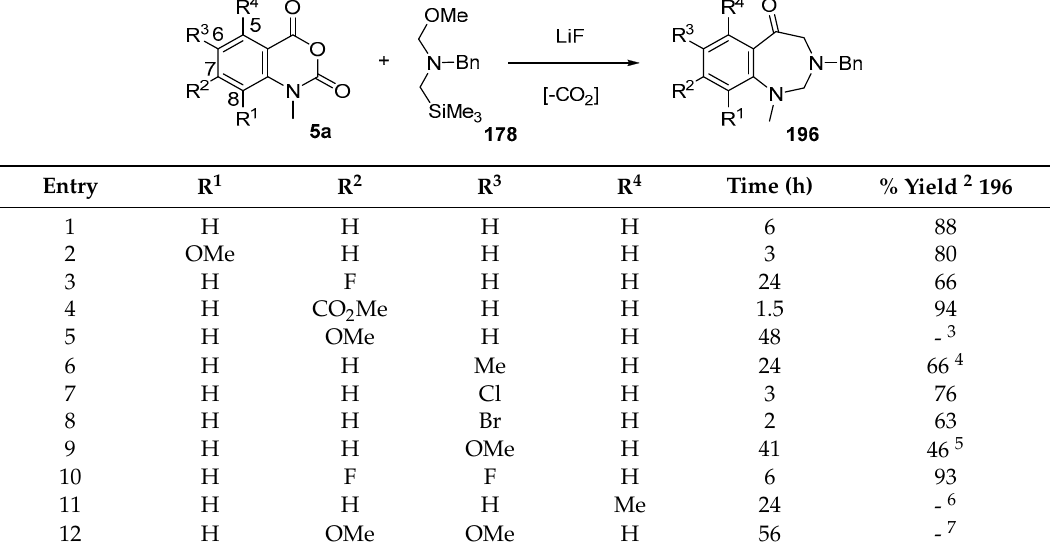
Table 26. Transformation of benzo-substituted N -methyl isatoic anhydrides 5a into 1,3-benzo-diazepin-5-ones 196 1 .